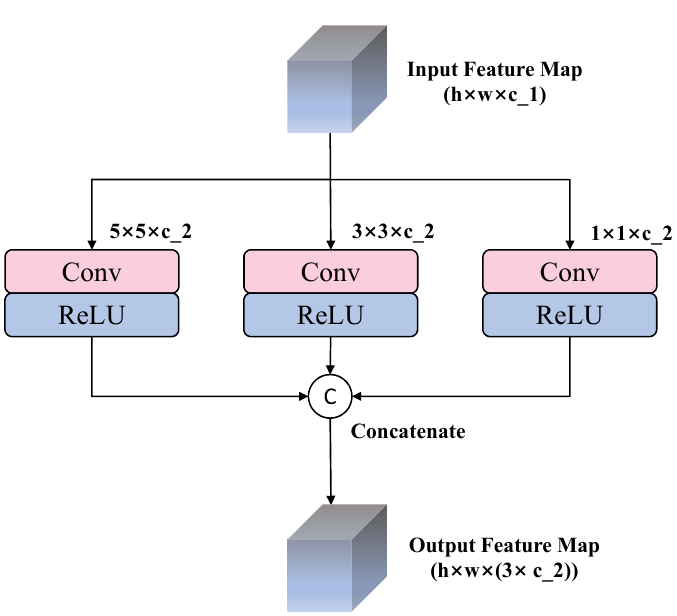
Figure 3. The architecture of Multiscale Feature Fusion Module, where h , w and c represent the sizes of feature maps and the kernel size of each convolutional layer is marked